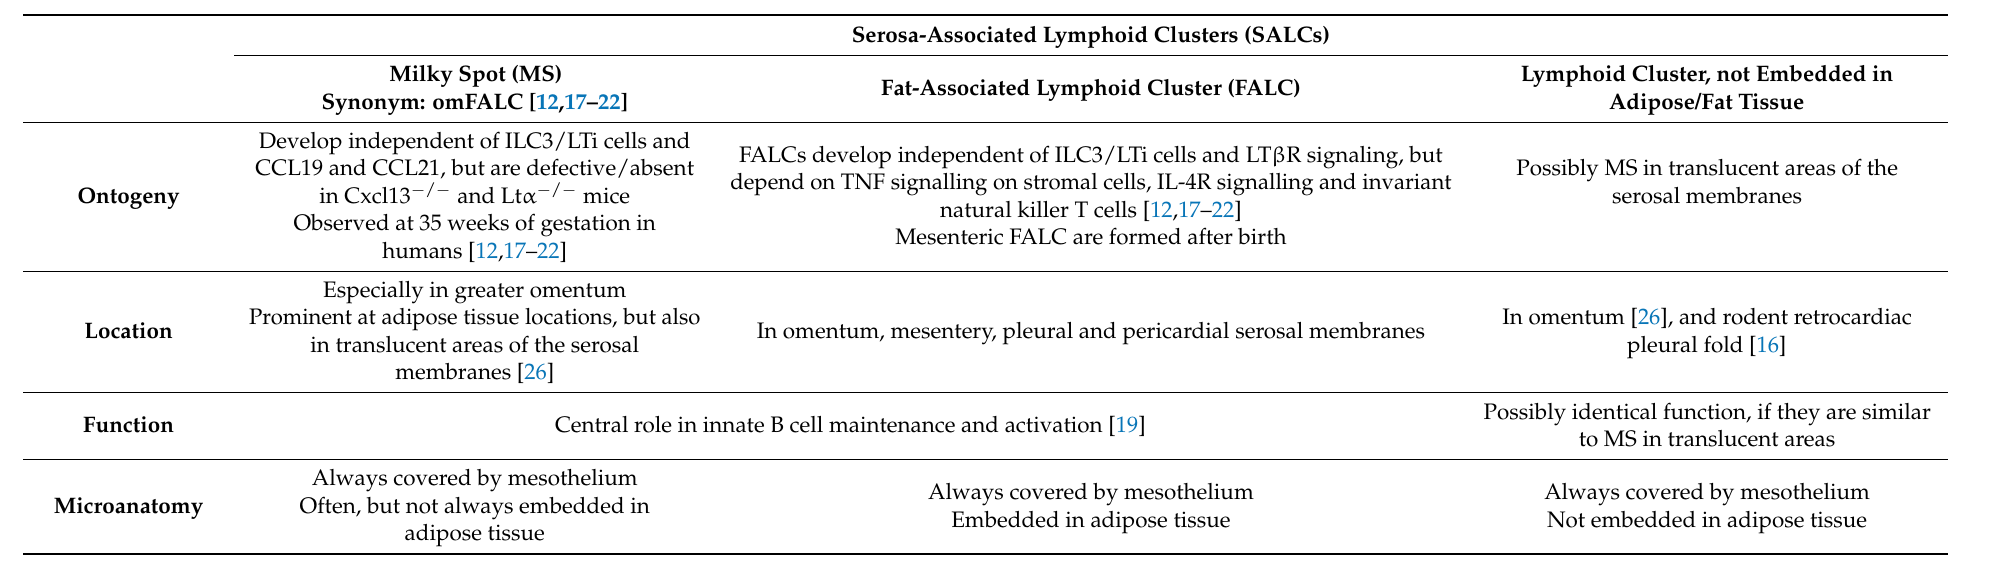
Table 1. Characteristics used to distinguish milky spots from fat-associated lymphoid clusters, grouped together as serosa-associated lymphoid